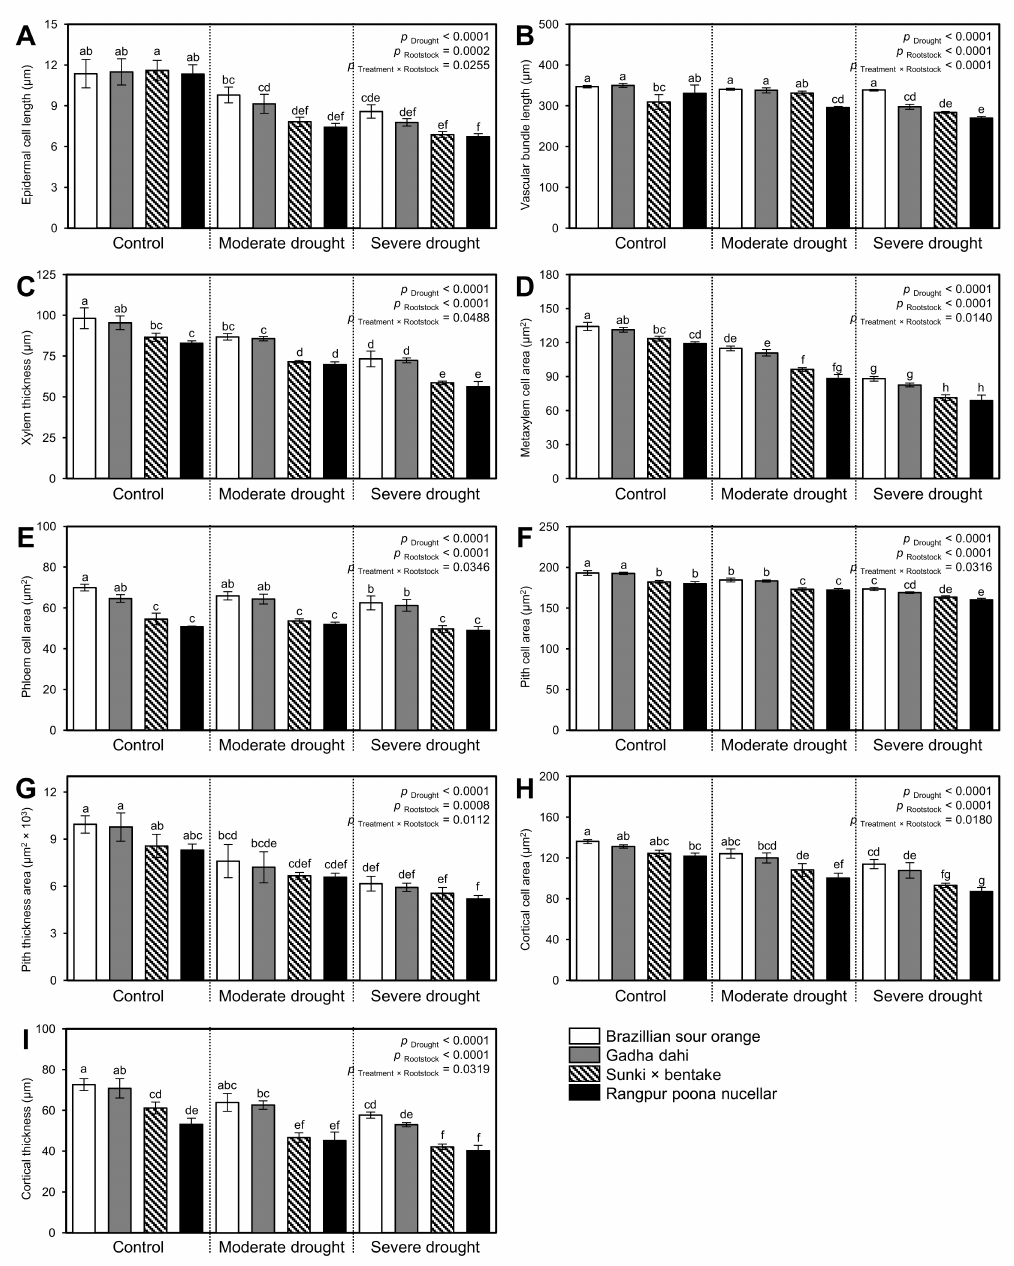
Figure 4. Effect of different water regimes on the stem anatomical features of two highly tolerant (Brazilian sour orange and Gadha dahi) and two highly sensitive genotypes (Rangpur Poona nucellar and Sunki × bentake). ( A ) Epidermal cell length ( µ m), ( B ) Vascular bundle length ( µ m), ( C ) Xylem thickness ( µ m), ( D ) Metaxylem cell area ( µ m 2 ), ( E ) Phloem cell area ( µ m 2 ), ( F ) Pith cell area ( µ m 2 ), ( G ) Pith thickness area ( µ m 2 × 10 3 ), ( H ) Cortical cell area ( µ m 2 ), and ( I ) Cortical thickness ( µ m). Data presented are means ± standard deviation (mean ± SD) of three biological replicates. Different letters indicate statistically significant differences among treatments, while “ns” signifies no significant differences between them according to Tukey’s honestly significant difference test ( p <